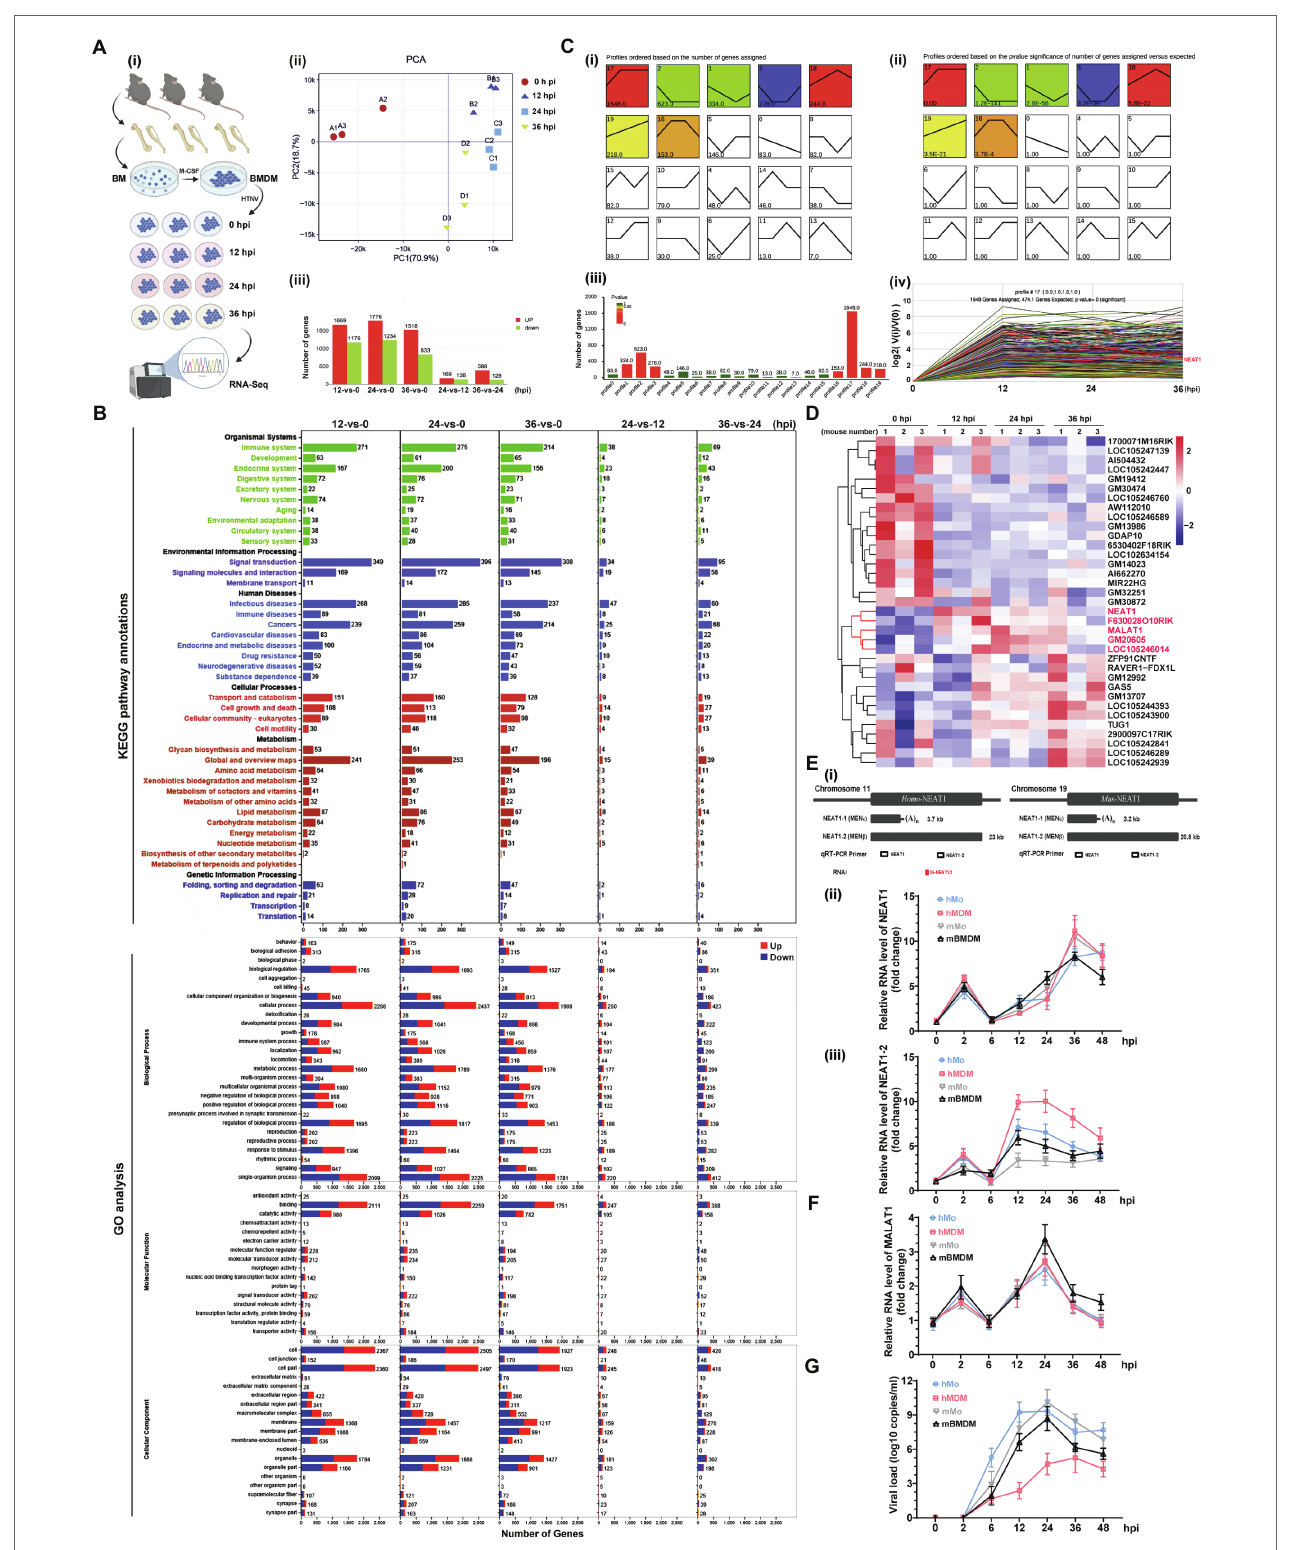
FIGURE 1 | RNA-seq analysis of HTNV-infected macrophages and lncRNA identification. (A) (i) Experimental design for RNA-seq. (ii) PCA of different groups. (iii) Analysis of differentially expressed genes between groups. (B) The KEGG pathway annotations (upper) and GO analysis (bottom) of RNA-seq data from A. (C) (i)